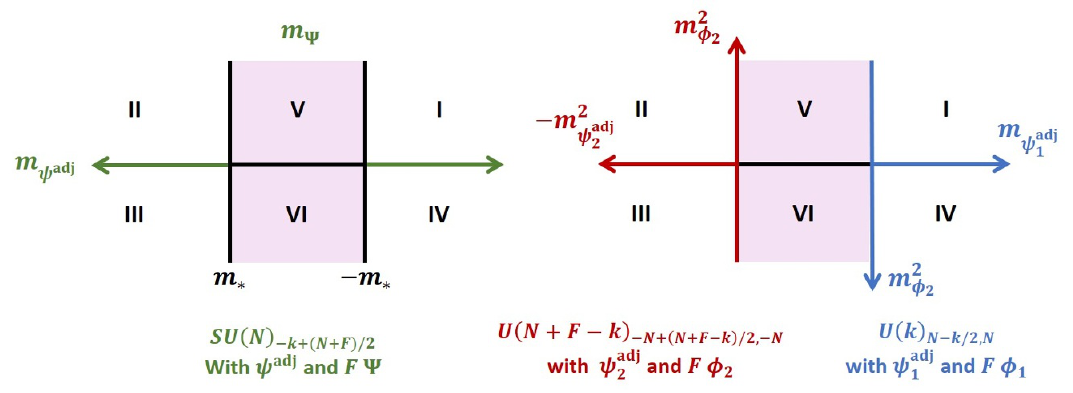
Figure 8 . Phase diagram of the 3d bosonization duality with both adjoint and fundamental representation matter. Here we assume N > k and F < k